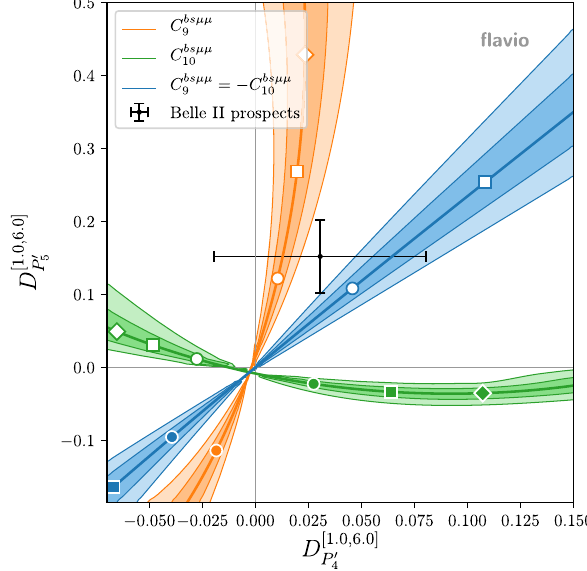
Fig. 2 Theory predictions for D P (cid:6) and D P (cid:6) in the presence of few 4 5 non-standard Wilson coefficients. The colored bands correspond to the 1 σ and 2 σ theory uncertainties. Circle, square, and diamond markers correspond to Wilson coefficient magnitudes of 0.5, 1.0, and 1.5. Col- ored markers correspond to positive, white markers to negative values. Also shown is the expected experimental precision with the full Belle II data set assuming a new physics benchmark point (black error